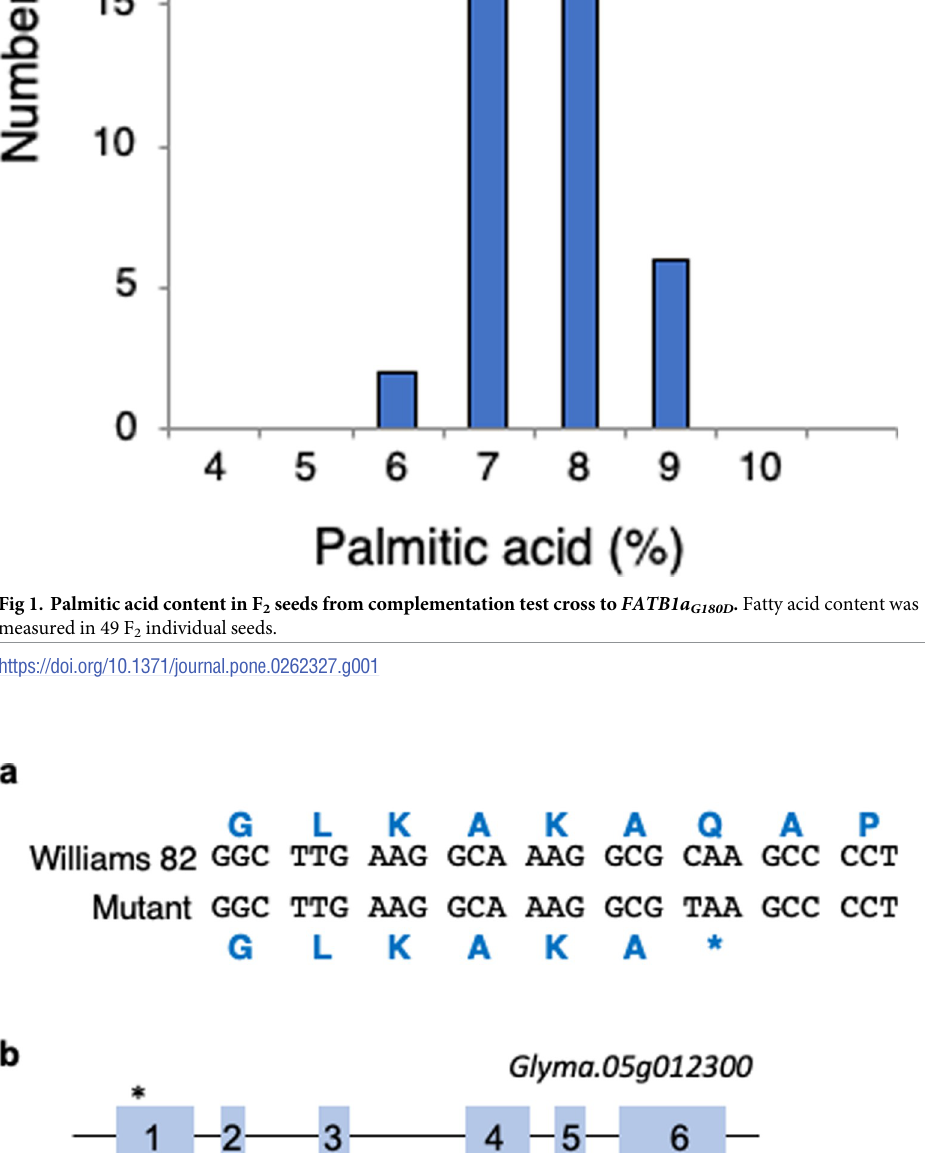
Fig 2. Polymorphism in FATB1a . a. DNA and predicted amino acid sequence (blue) of the FATB1a gene (Glyma.05g012300) in Williams 82 soybean and the mutant. b. Early termination signal ( � ) occurs within the first exon of the predicted